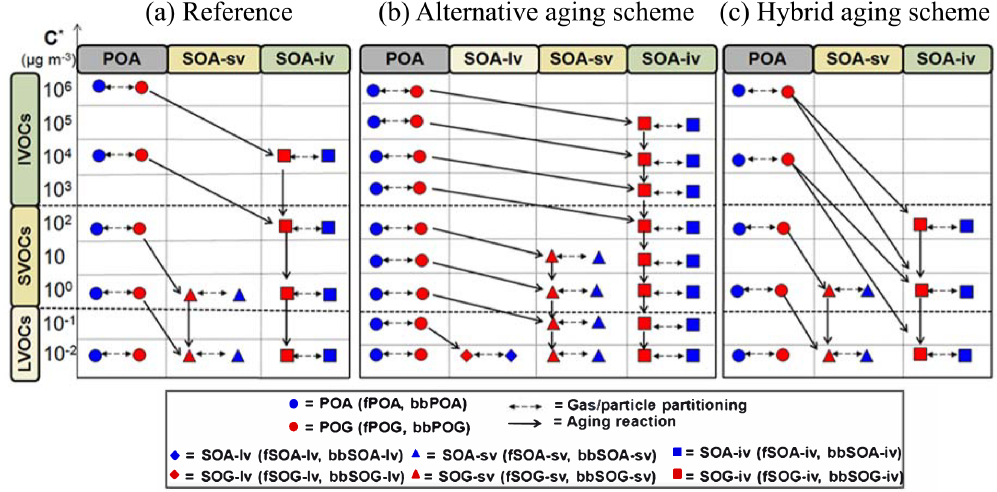
Figure 1. Schematic of the VBS resolution and the formation of SOA from SVOCs and IVOCs in the (a) reference simulation, (b) alternative aging scheme, and (c) hybrid aging scheme. SOA from LVOCs (SOA-lv) is only formed in the alternative aging scheme (b) . Red indicates that the organic compound is in the vapor phase and blue in the particulate phase. The circles correspond to primary organics emitted as gases or particles. Diamonds symbolize the formation of SOA from LVOC emissions by fuel combustion and biomass burning. Triangles indicate SOA formation from SVOC emissions by fuel combustion and biomass burning, while the squares show SOA from IVOCs by the same sources. Gas–aerosol partitioning, aging reactions, and names of species are also